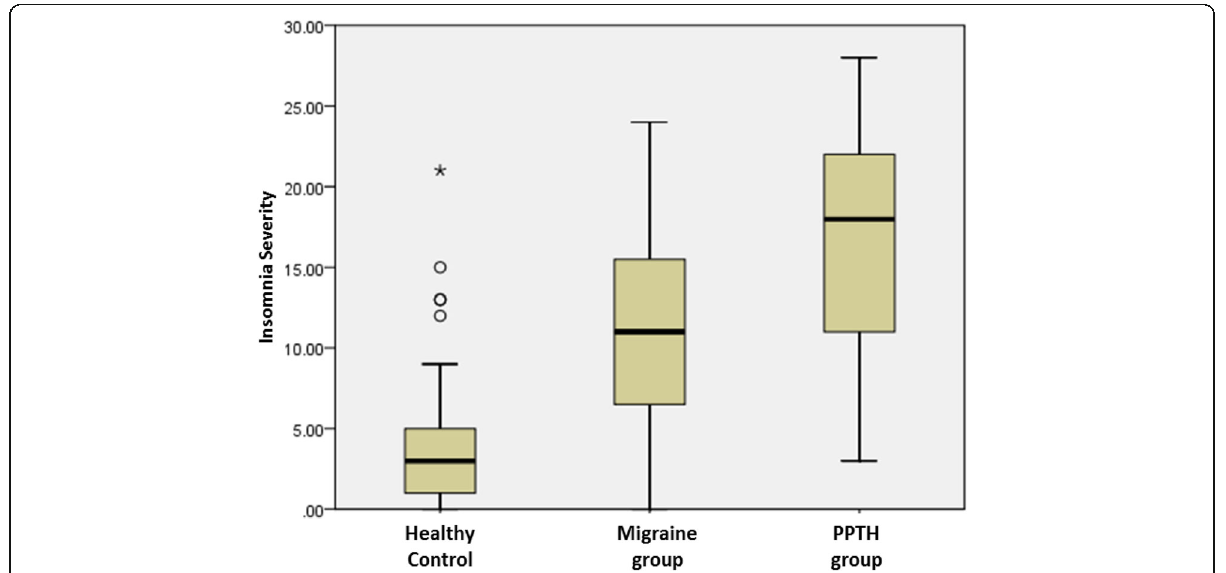
Fig. 1 Insomnia Severity Index scores among groups. PPTH: Persistent posttraumatic